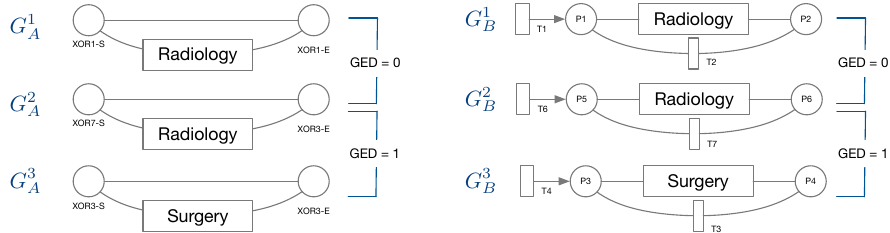
Figure 3. Intuition for graph-based similarity. Left: for graphs constructed from IvM models; right: for graphs constructed from Petri nets. Event nodes match only if they represent the same event. Other nodes match if they have the same type, e.g., represent the start of an XOR branch (XOR-S), independent on the ID of the graph